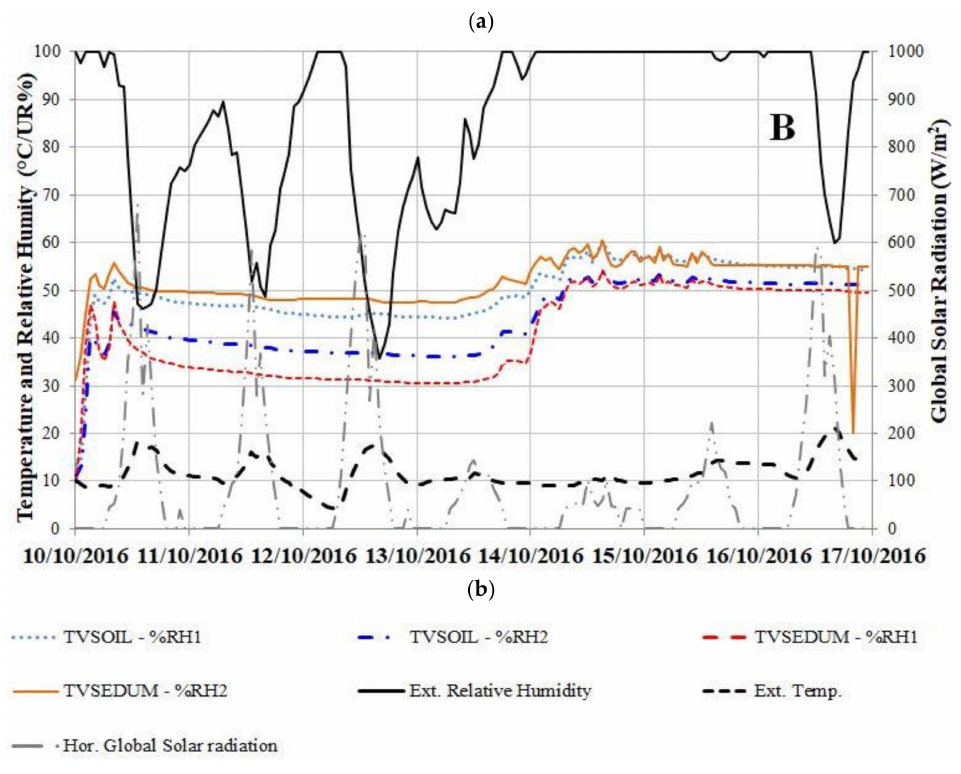
Figure 10. Internal moisture contents of growing media for the week from 6 December to 12 December 2016 ( a ); and the week from 10 October to 16 October ( b ) with TVSOIL and TVSEDUM.